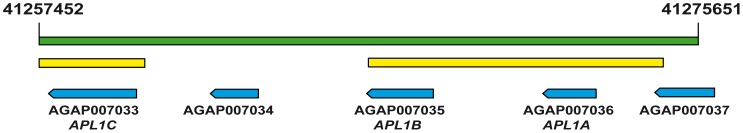
Genomic organisation of the A. gambiae APL1 region.The genomic region of the 2L chromosome that comprises the APL1 locus is indicated by a green bar (A. gambiae reference genome [23], genome assembly AgamP3). The bar delimits the region of the genome that has been completely spanned with overlapping PCR amplicons. The chromosomal positions are indicated (in bp) on top of the bar. The yellow bars indicate the regions for which overlapping PCR fragments have been sequenced. Blue arrows represent the genes in this chromosomal region and their direction of transcription. The last two lines indicate gene identifiers and names.